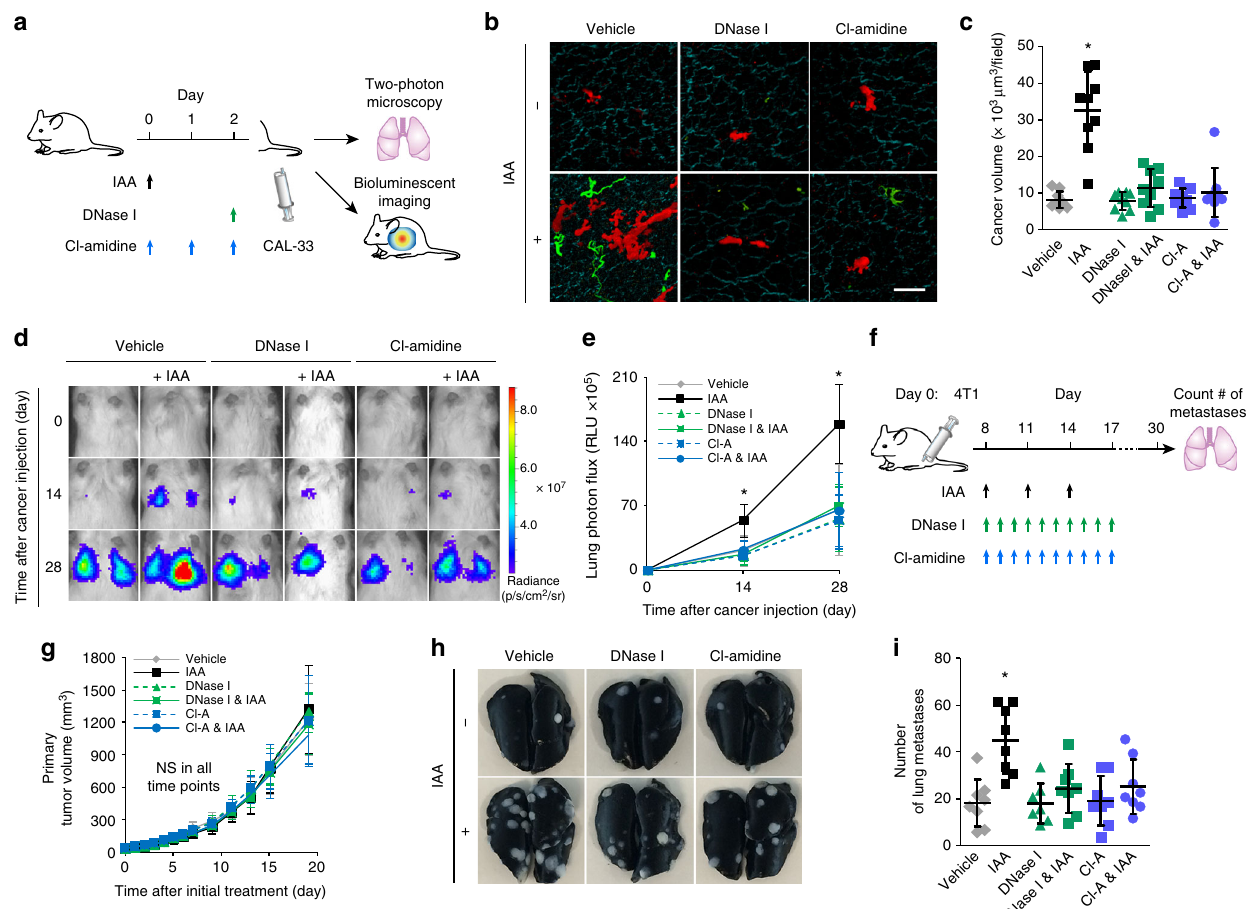
Fig. 4 Plasma redox imbalance promotes lung metastasis via NETs. a Experimental schema for ( b – e ): the effect of NETs induced by albumin-thiol blocking on pulmonary metastasis following tail vein injection of CAL-33 HNSCC cells. Saline or IAA (30 mg/kg) was injected intraperitoneally into NSG mice. DNase I or Cl-amidine was administered at the indicated time points. Two day later, SytoxGreen and CAL-33-mCherry cells ( b , c ) or CAL-33-luciferase ( d , e ) were injected. b , c Extracellular DNA (green), CAL-33-mCherry cells (red), and surrounding collagen-rich parenchyma (cyan) within resected lungs were visualized by two-photon microscopy. ( b ) Representative images are shown. Bar = 50 μ m. c Quanti fi cation of the mCherry-positive volume from two- photon microscopy images of resected lungs. d , e The growth of pulmonary metastases was monitored by bioluminescence imaging. d Representative images are shown. e Luciferase bioluminescence intensity from the lungs over time (0 – 28 days). f Experimental schema for ( g – i ): the effect of NETs induced by albumin-thiol blocking on a spontaneous pulmonary metastasis model. 4T1 murine mammary carcinoma cells were orthotopically transplanted to the mammary fat pads of female Balb/c mice. Saline or IAA (30 mg/kg) was injected intraperitoneally at the indicated time points. Between 8 to 17 days after transplantation, saline, DNase I, or Cl-amidine was administered daily. g Primary tumor growth. NS not signi fi cant. h , i Lungs were removed 30 days after transplantation. h Representative images are shown. i Number of metastatic lung colonies. ( c, i ) Results represent individual values with the mean ± s. d. e , g Results represent the mean ± s.d. c n = 9 per group: three fi elds in three independent experiments. e n = 5 per group; one of the mice in the DNase I & IAA group died on day 1 for unknown reasons. g , i n = 8 per group; one of the mice in the DNase I group died on day 14 for unknown reasons. * P <